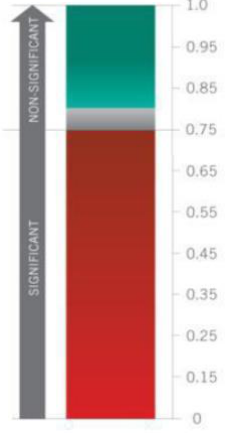
Figure 1. Scale of FFR values [1]